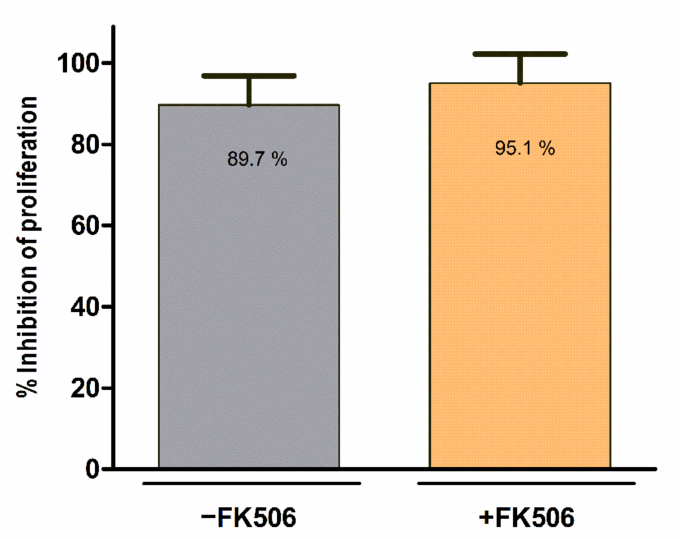
Figure 2. Immunopotency assay for MSC in presence or absence of FK506. Both conditions tested resulted in pronounced inhibition of the proliferation of stimulated NC in culture. Values of inhibition of proliferation in co-cultures of MSC,WJ:NC were normalized to proliferating stimulated NC in absence of